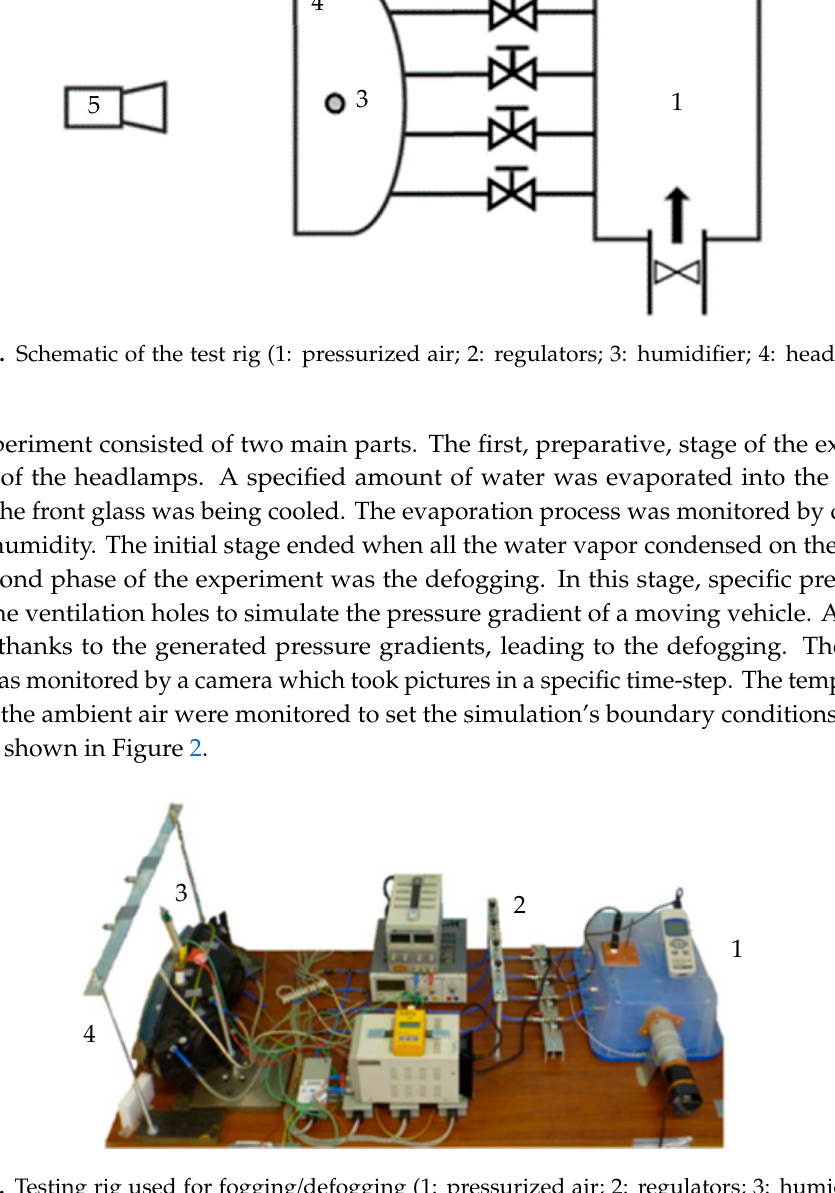
Figure 2. Testing rig used for fogging / defogging (1: pressurized air; 2: regulators; 3: humidifier; 4: